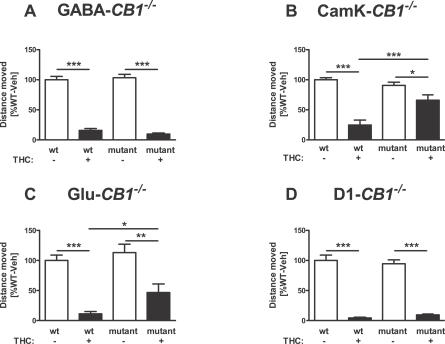
Effect of THC on Locomotor Activity of Different CB1 Mutant MiceHorizontal locomotor activity was recorded for 15 min, 60 min after the injection of 10 mg/kg THC or vehicle. Values were recorded in cm and normalized to vehicle-treated wild-type animals of each mutant line (100%). *, **, ***; p < 0.05, p < 0.01, p < 0.001, respectively. (two-way ANOVA, followed by Newman-Keuls post-hoc test). Note the normal effect of the drug in GABA-CB1
−/− (A), the impaired effect in CaMK-CB1
−/− (B), and in Glu-CB1
−/− (C), and the normal effect in D1-CB1
−/− mice (D). For D1-CB1
−/−, see text for a slight impairment in the relative effect of THC. See Materials and Methods for number of animals in each group.